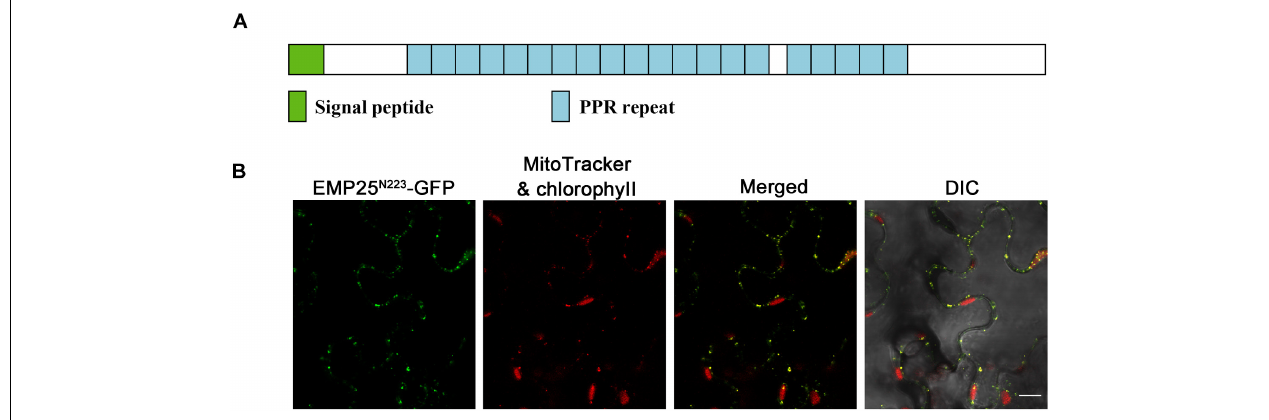
FIGURE 3 | EMP25 is a mitochondrion-localized P-type PPR protein. (A) Schematic diagram of the EMP25 protein. (B) Subcellular localization of EMP25. The N-terminus (223 amino acids) of EMP25 was fused with the green fluorescence protein (GFP). The EMP25 N223aa –GFP fusion was transiently expressed in tobacco leaf epidermal cells and the signal was detected by confocal fluorescent microscopy. Mitochondria were detected with MitoTracker. DIC, differential interference contrast. Scale bar = 10 µ